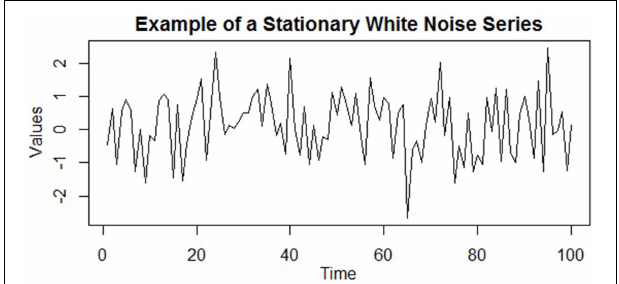
FIGURE 4 | An example of a stationary time series (specifically, a series of uncorrelated white noise terms). The mean, variance, and autocorrelation are all constant over time, and the series displays no systematic patterns, such as trends or cycles.